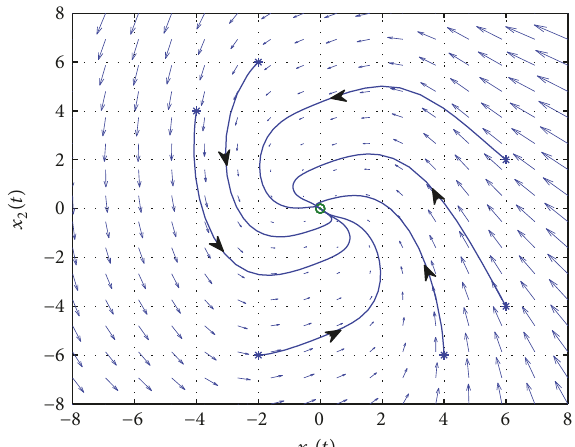
Figure 1: Behaviors of nonlinear system (47) in 𝑥 1 − 𝑥 2 plane.